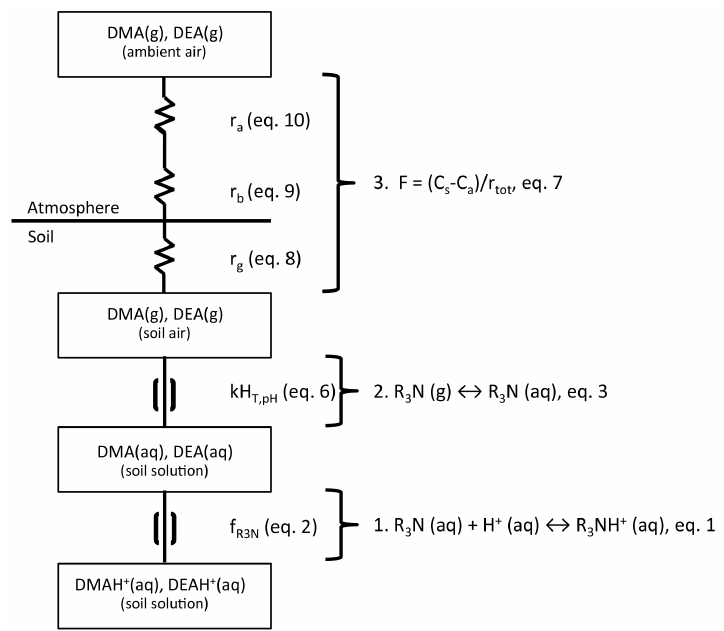
Figure 1. Scheme used for soil–atmosphere flux estimation of dimethylamine (DMA) and diethylamine (DEA) from reactions occurring in soil solution to transfer from soil air to ambient air. Boxes denote DMA and DEA concentrations in soil solution, soil air, and ambient air. Numbers denote for steps in the flux estimation. Step 1: acid–base reaction and protonation of alkylamine; step 2: partitioning of non- protonated DMA and DEA between aqueous and gas phases; step 3: flux of DMA and DEA between soil and ambient air in which flux is determined by dividing concentration gradient by sum of component resistances (soil resistance, r g ; quasi-laminar boundary-layer resistance, r b ; aerodynamic resistance, r a )